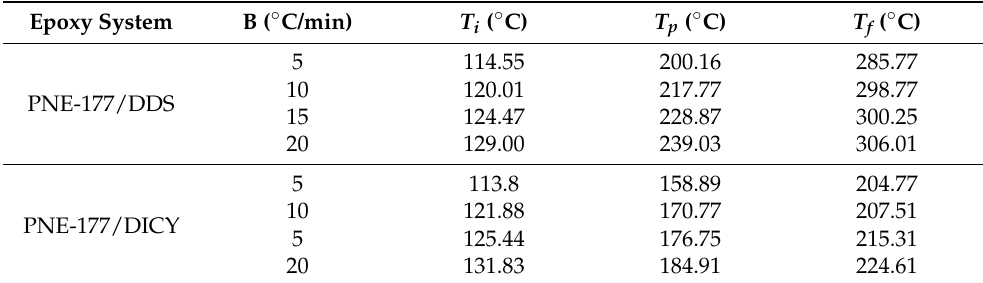
Table 1. The characteristic temperatures of the pure epoxy/curing agent